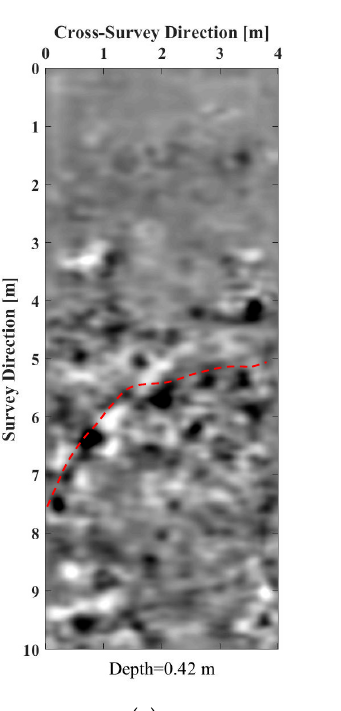
Figure 8. Migrated horizontal slices at different depths. Red lines indicate the detected roots in the migrated data set. ( a ) Migrated slice at 16-cm depth; ( b ) migrated slice at 19-cm depth; ( c ) migrated slice at 27.5-cm depth.